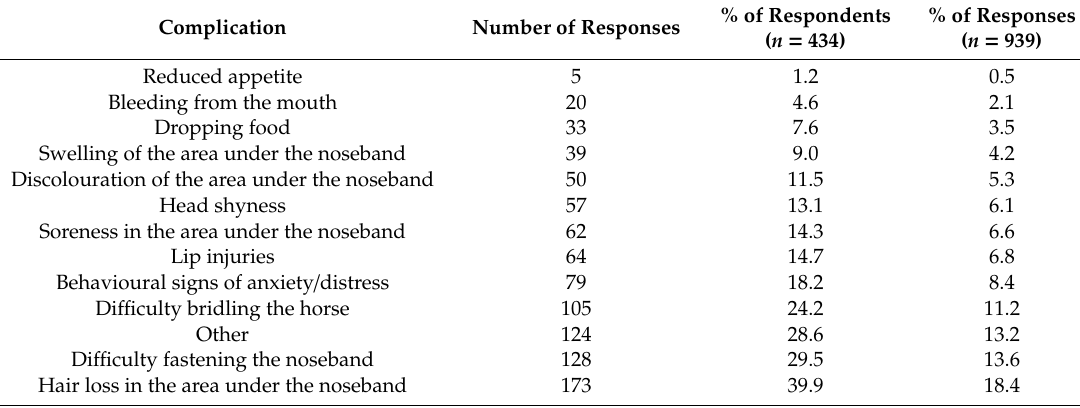
Table 8. The distribution of complications reported by respondents who used nosebands, ranked from least number of responses to most. In total, 552 respondents reported one or more complications, with 939 individual complications recorded. The per cent of respondents who reported a complication is represented in the third column, with the per cent of the complication out of the total number of complications reported in the fourth